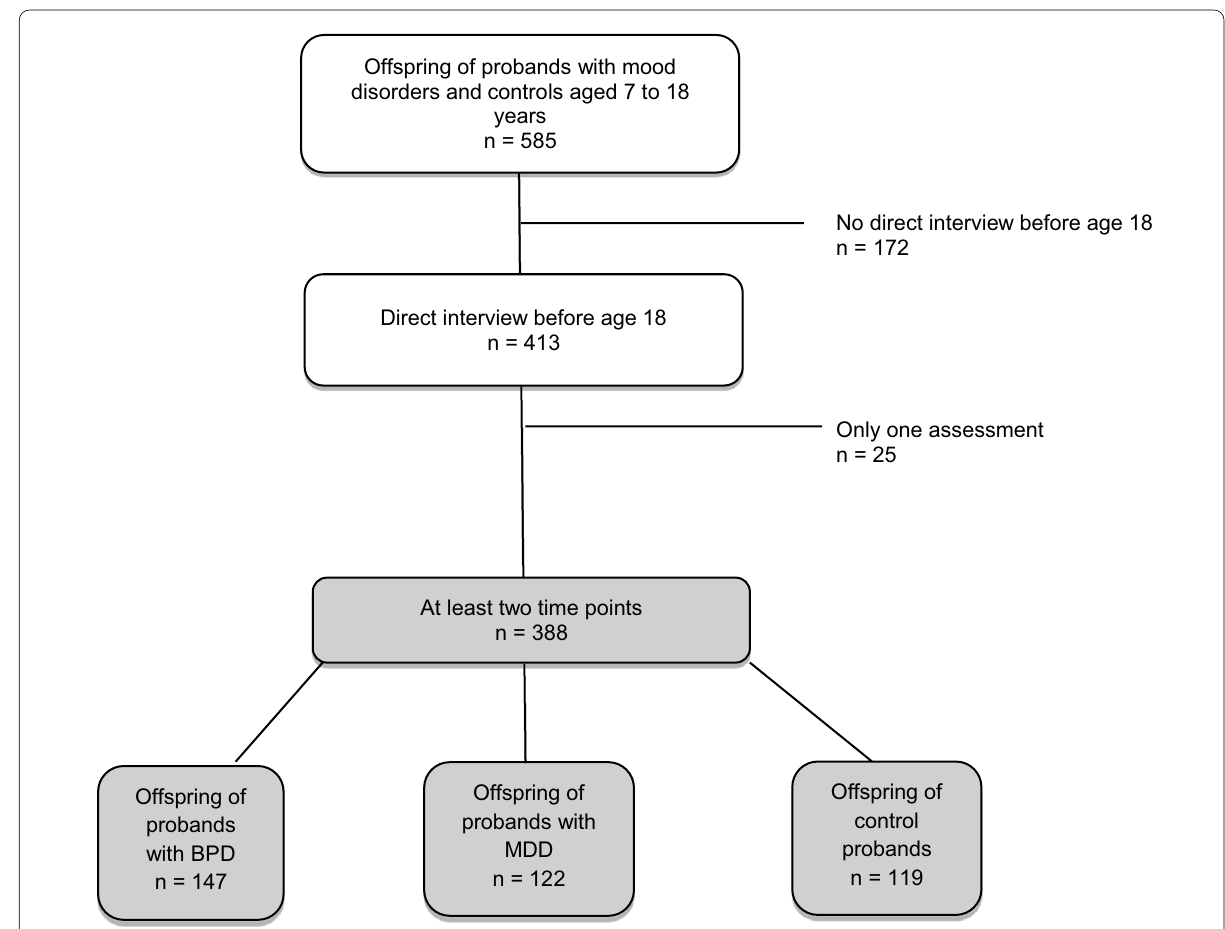
Fig. 1 Flow chart of the sample selection of offspring of parents with mood disorders and controls. BPD bipolar disorders, MDD major depressive disorders